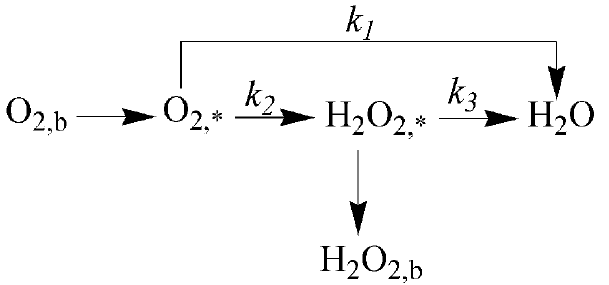
Figure 9. Possible routes for oxygen reduction. Footnotes b and * indicate reactions in the bulk solution and reaction on the electrode surface, respectively.